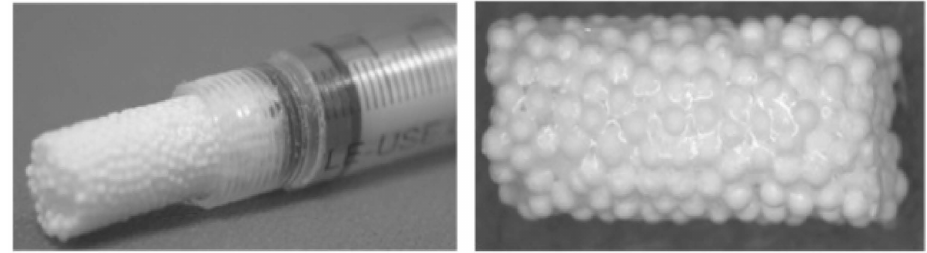
Figure 7. A 3D-formed composite of β -tricalcium phosphate beads and alginate [61].